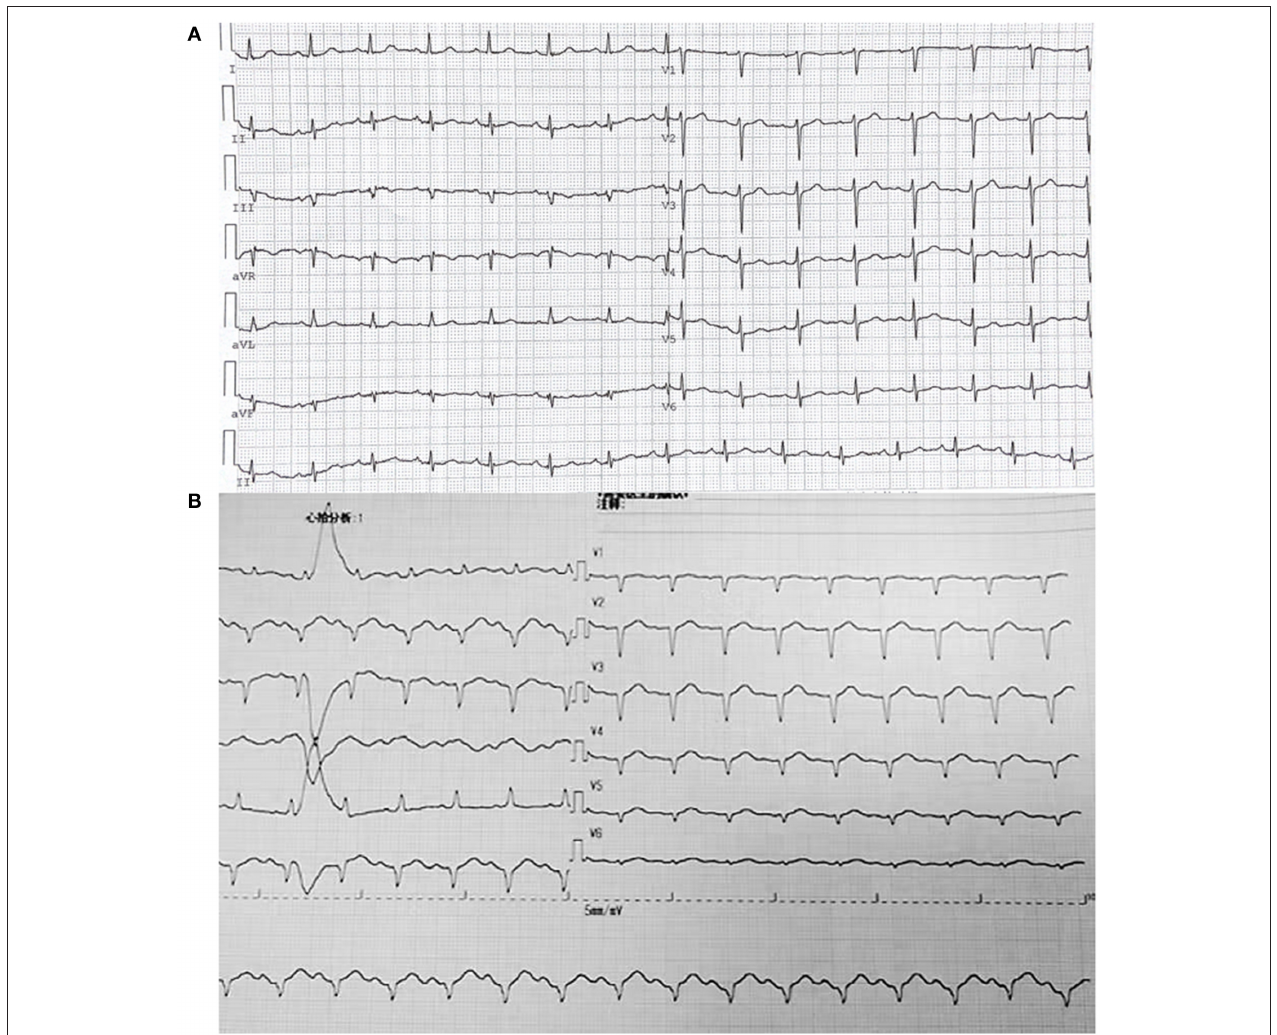
FIGURE 1 | Electrocardiogram (A) Before the surgery; Electrocardiogram (B) After return of spontaneous circulation